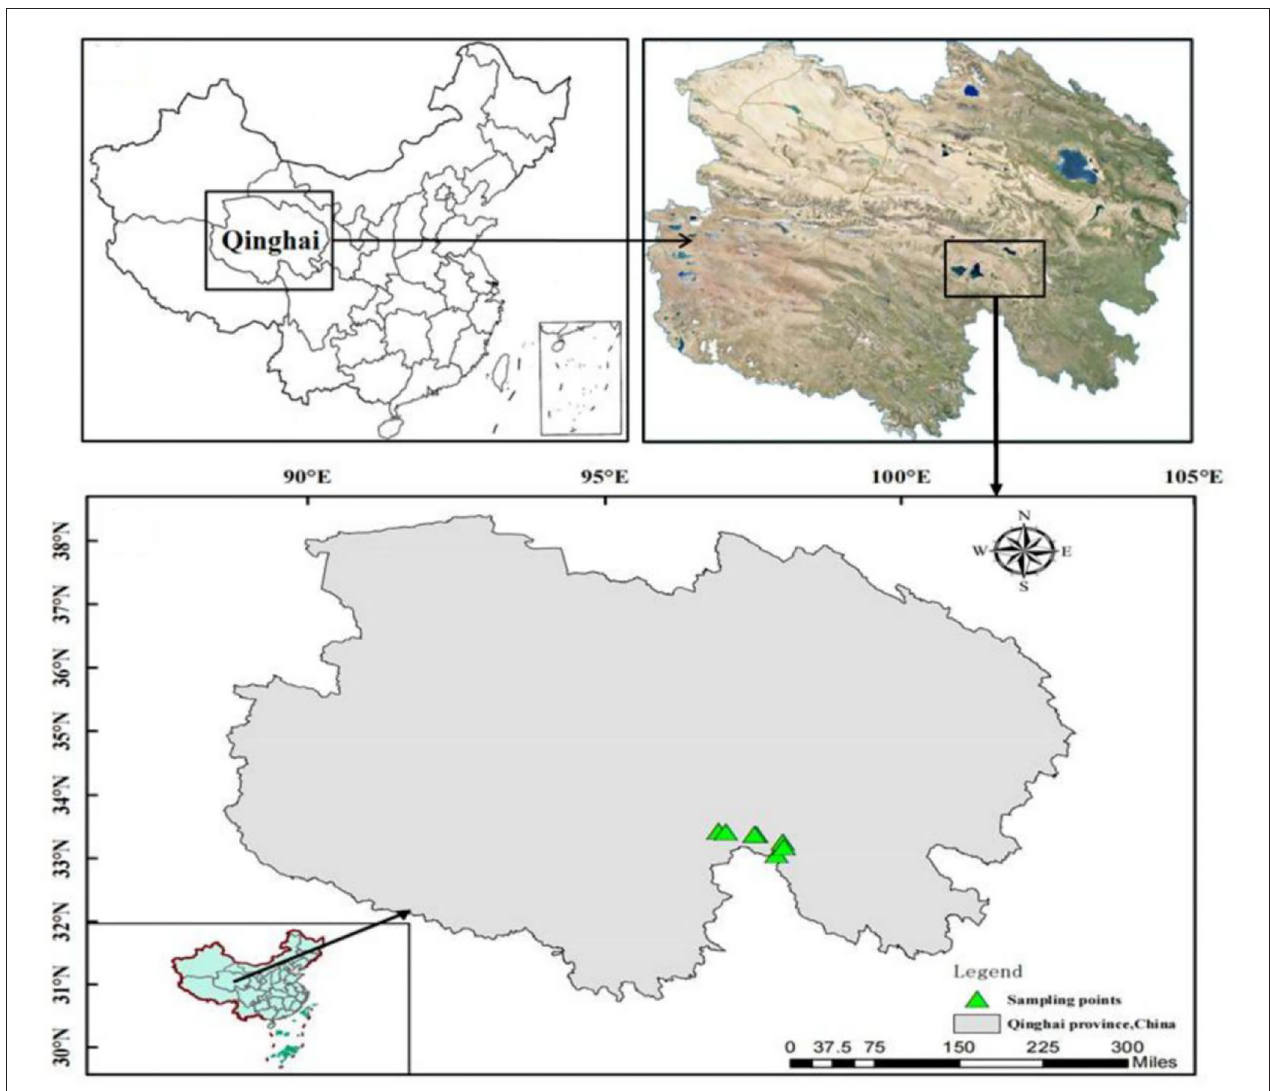
FIGURE 1 | Location map of sampling